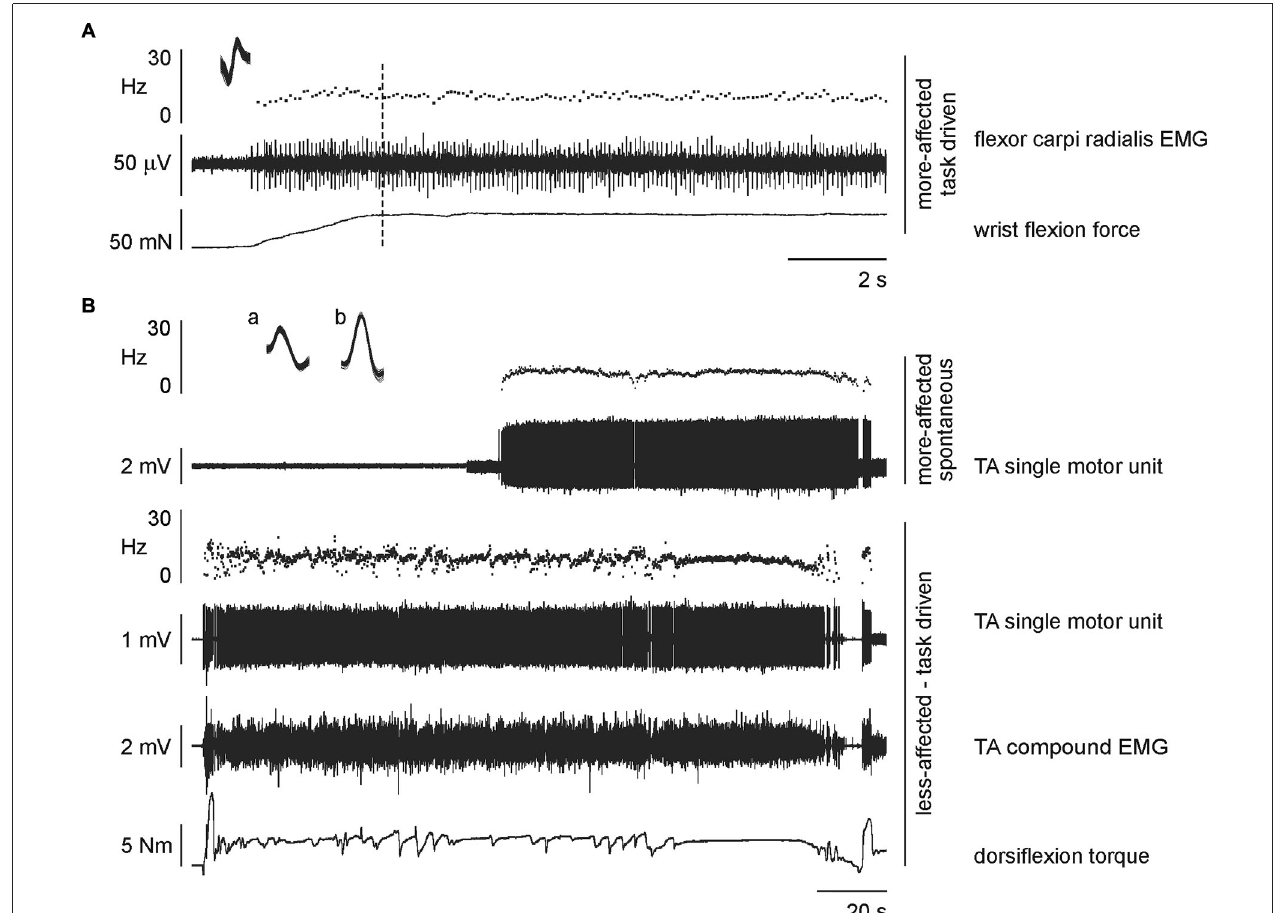
a unitary recording. (B) concurrently recorded units during dorsiflexion of the less-affected tibialis anterior by a 72 year old male, 39 months post-stroke. The single motor unit on the active less-affected side is task-driven with activation relating to the total torque output (discharge rate 9.55 ± 0.05 Hz, mean and SEM; superimposed spikes marked a). The single motor unit on the passive more-affected side is spontaneously active and unrelated to the task on the contralateral leg (discharge rate 8.85 ± 0.03 Hz, mean and SEM; superimposed spikes marked